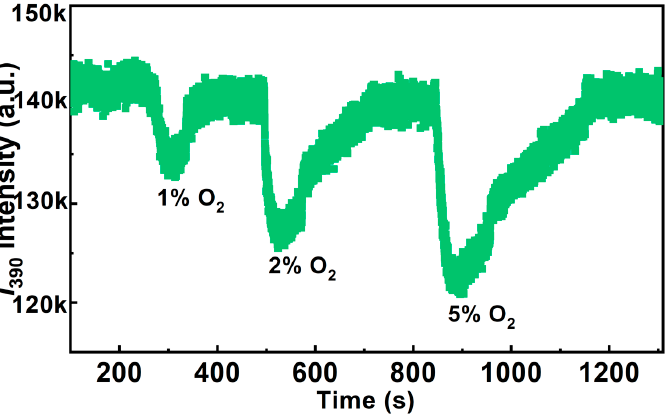
Figure 7. Dynamic response of Au/ZnO NRs with exposure to 1–5% oxygen atmospheres.